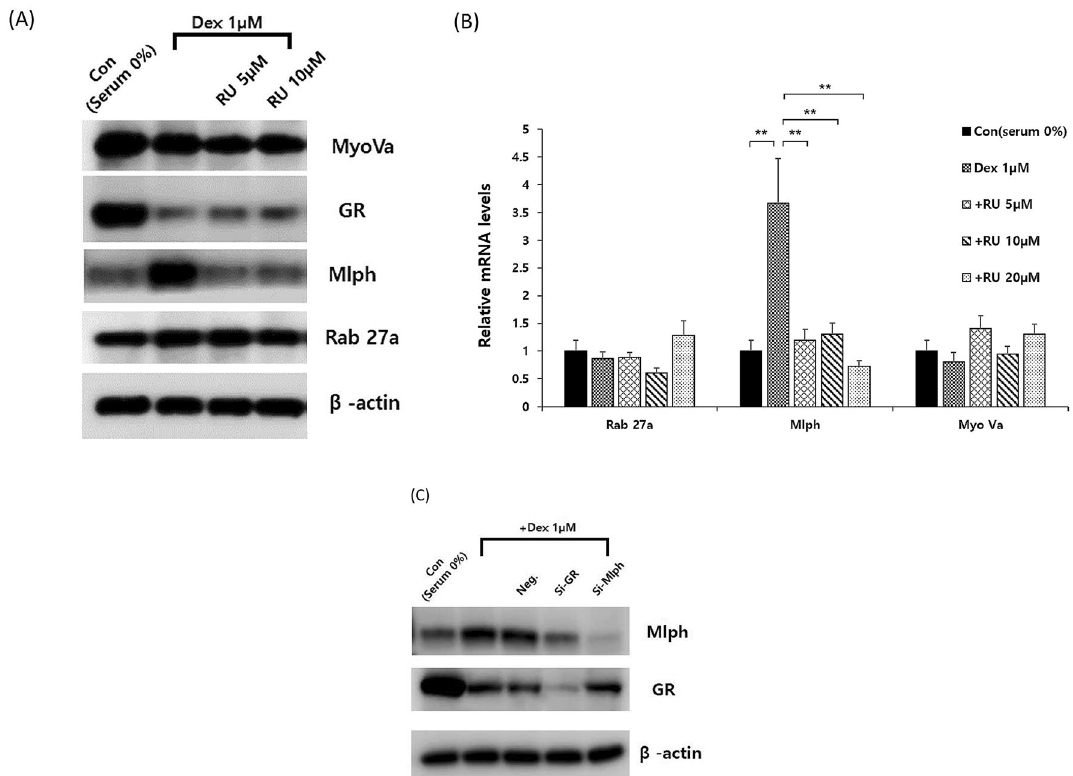
Figure 3. GR activation only regulates Mlph expression among the melanosome transport proteins. ( A ) Expression levels of melanosome transport proteins. Melan-a melanocytes were cultured in serum-free media with 1 µM Dex for 72 h or with RU486 at the concentration noted for 30 min before Dex exposure, after which cell extracts were subjected to western blotting. ( B ) mRNA expression levels of melanosome transport proteins. Melan-a melanocytes were cultured in serum-free medium with 1 µM Dex for 24 h with or without RU486 pretreatment for 30 min. mRNA expression levels were quantified by q-PCR. ( C ) Effect of altering GR activity on GR and Mlph expression. Melan-a melanocytes were cultured in serum-free medium with 1 µM Dex for 72 h after GR and Mlph siRNA transfection. Protein expression was measured using western blotting. All data in this figure represent the mean ± SD of three independent experiments. Data were analyzed by Student’s t-test. ** P < 0.01, *** P < 0.001. The band intensity was quantified using NIH ImageJ software 1.45 s and normalized relative to β-actin. Original images and quantification were provided in Supplemental